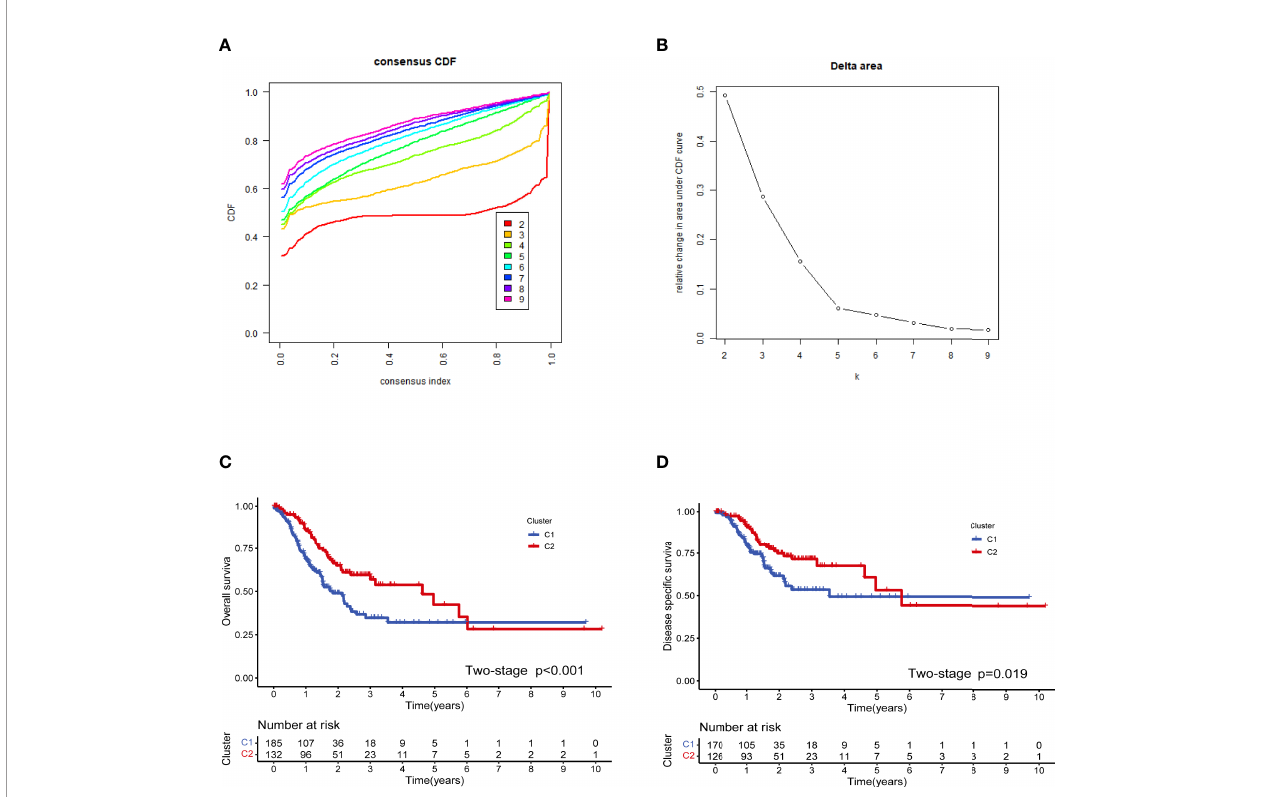
FIGURE 2 | Cluster analysis based on the costimulatory molecule gene (CMG) expression pro fi les. The optimal value for consensus clustering (A, B) was found to be k = 2. Kaplan – Meier curve for the disease-free survival in the stomach adenocarcinoma (STAD) group (C) . Kaplan – Meier curve for the total survival in the STAD group (D)